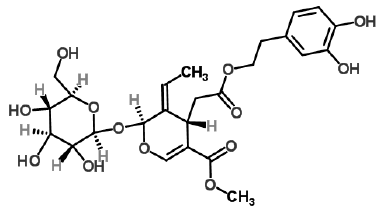
Figure 1. Chemical structure of oleuropein [19].